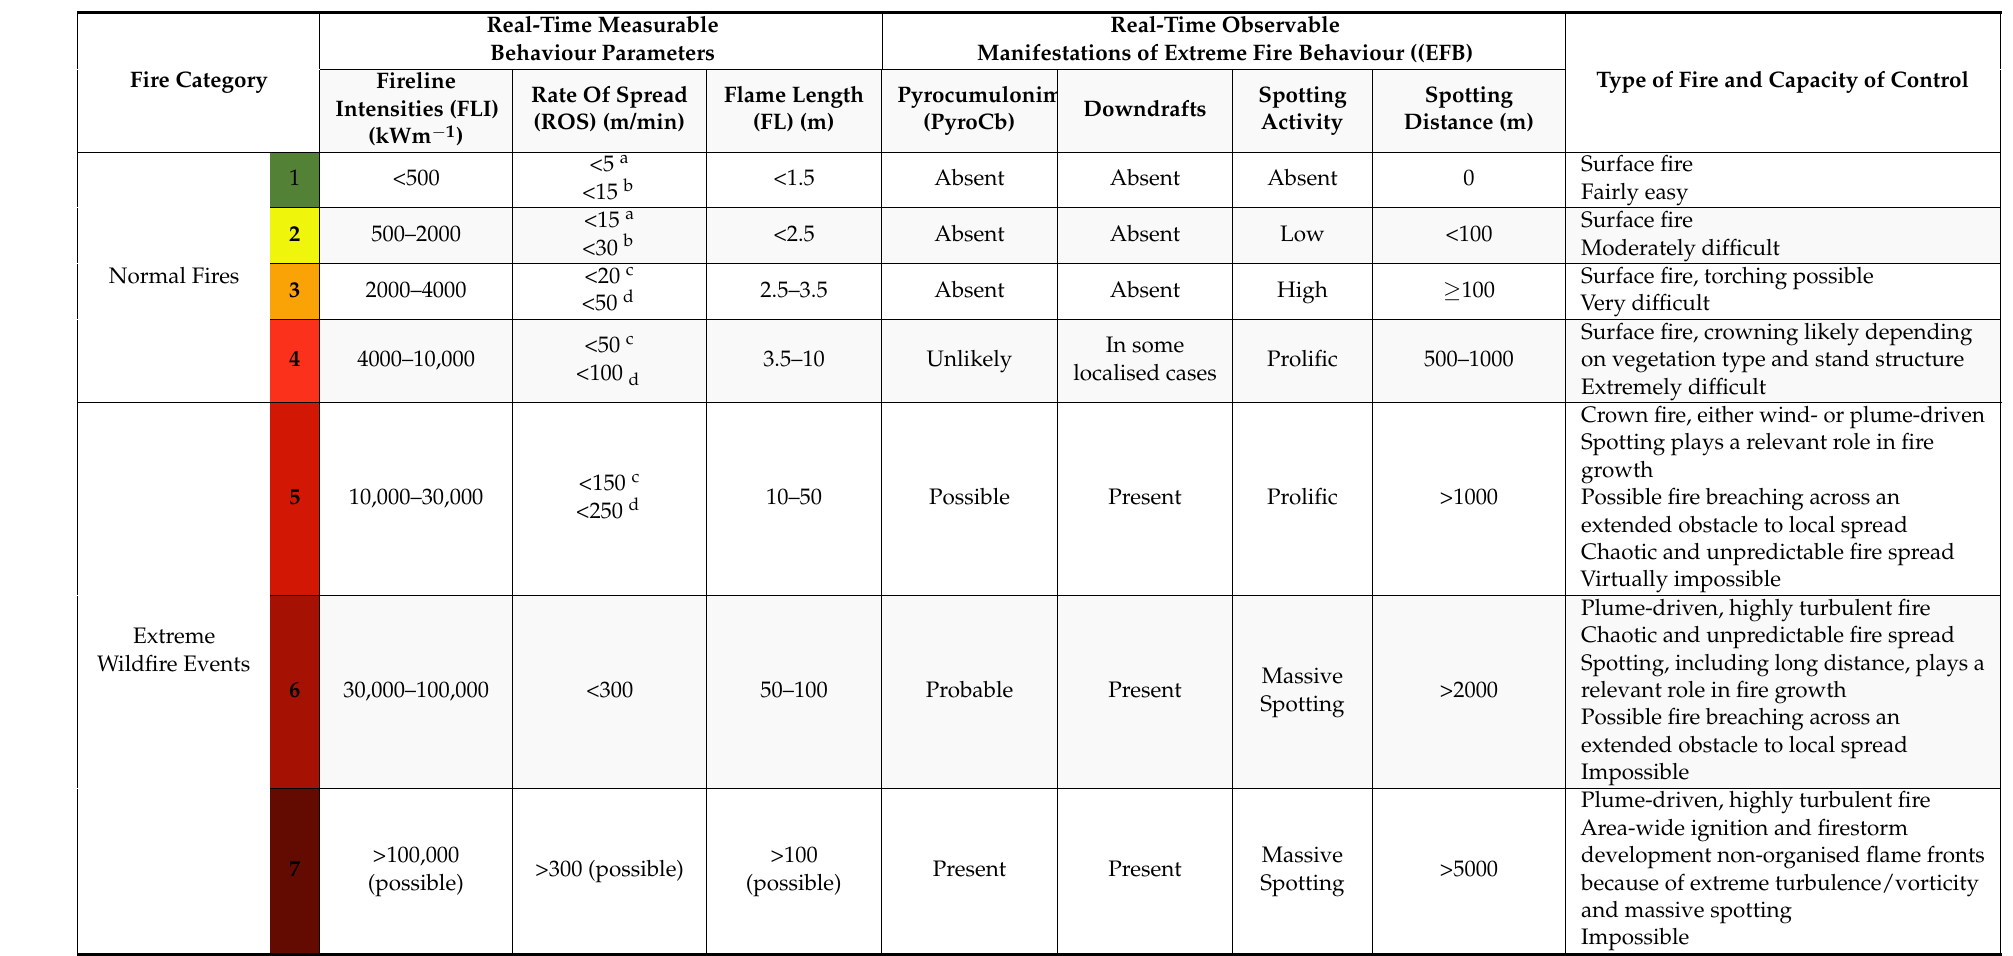
Table 3. Classification of wildfires based on fire behaviour and the capacity of control. Adapted from